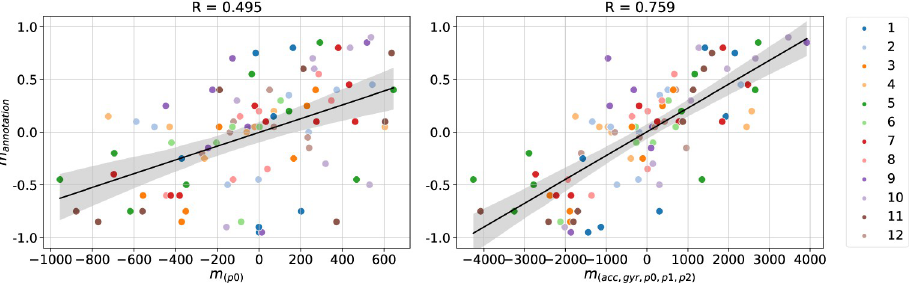
Fig 4. Effect of input features on Pearson correlation. The scatter plots represent dataset D inter with unique colours associated to participants. The DTW differences against the ratings displayed a stronger linear relationship with all input features included (right) than with just the position (left). These two combinations were chosen as they exhibit the worst and best performance from Table